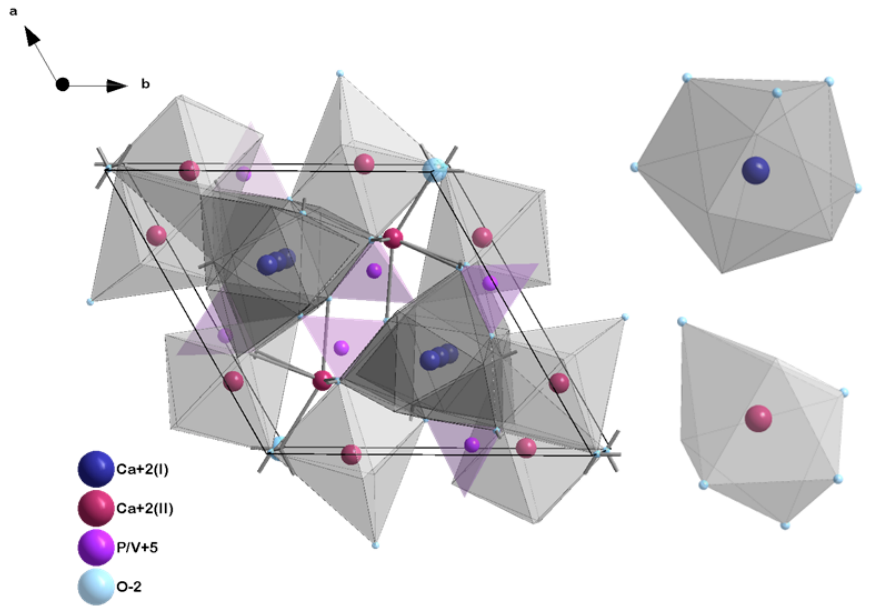
Figure 1. Unit cell of HVp structure. Ca(I) and Ca(II) sites are distinguished, and both Sr 2+ and Tb 3+ ions can be located during substitution.